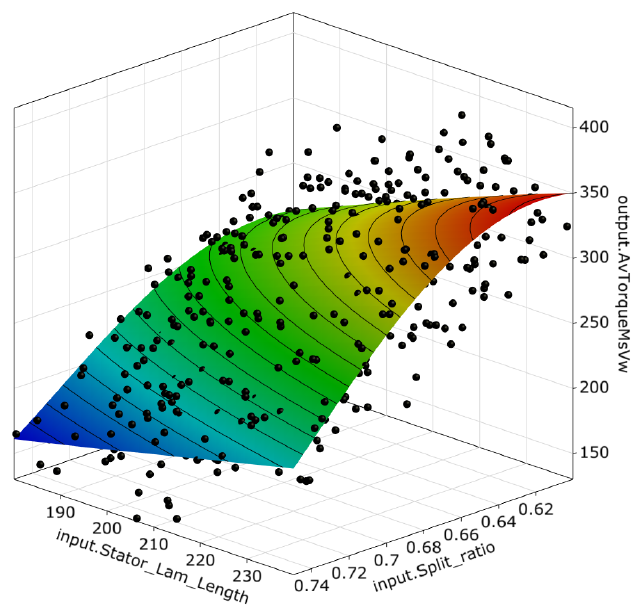
Figure 11. Example of torque response MOP (black dots are the sampling data calculated during the sensitivity analysis).